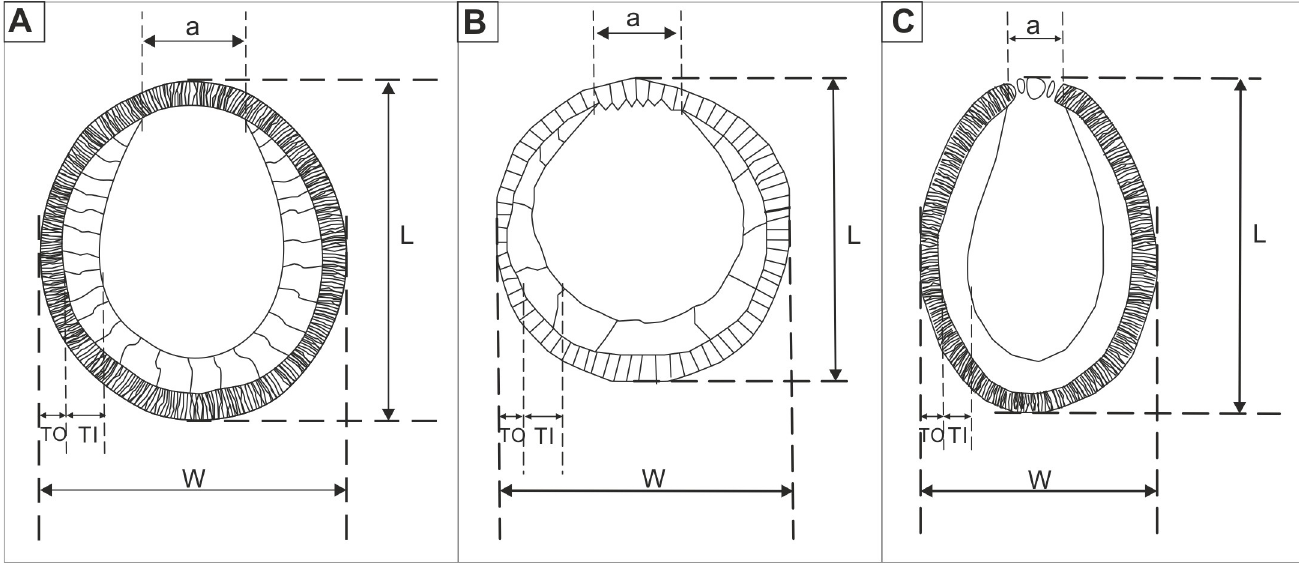
Fig 6. Schematized outline of test with two layers (outer and inner) in longitudinal section of (A) Cadosinopsis rehakovii sp. nov. (based on holotype and paratypes cross-sections), (B) Cadosinopsis nowaki Borza, 1984, (based on Borza, 1984), (C) Cadosinopsis andrusovi Scheibner, 1967 (based on Scheibner, 1967). Not for scale. L–length, W–width, TO–greatest thickness of outer layer, TI–thickness of inner layer, a–aperture.